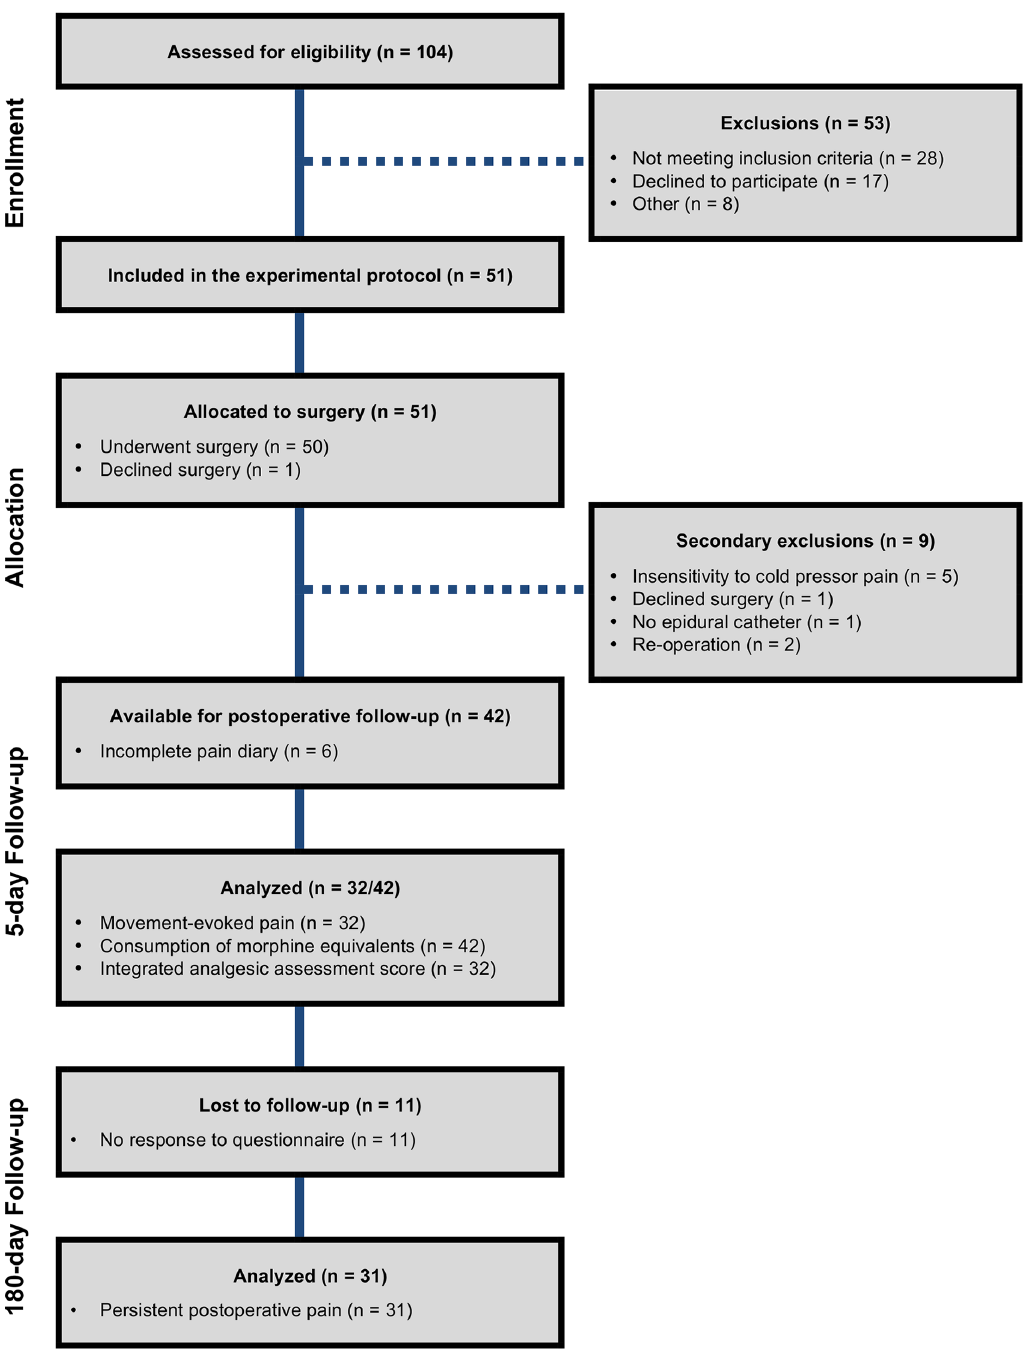
Figure 2. Flow chart. Illustration of the patient selection process, reasons for exclusion and number of patients analyzed for the primary and secondary outcomes. Situational pain catastrophizing explained 23% of the varia- tion in postoperative movement-evoked pain intensity ( P = 0.004; Table 3, Model 2). The significant association between situational pain catastrophizing and pain intensity remained when statistically adjusted for anxiety and depression ( P = 0.007;